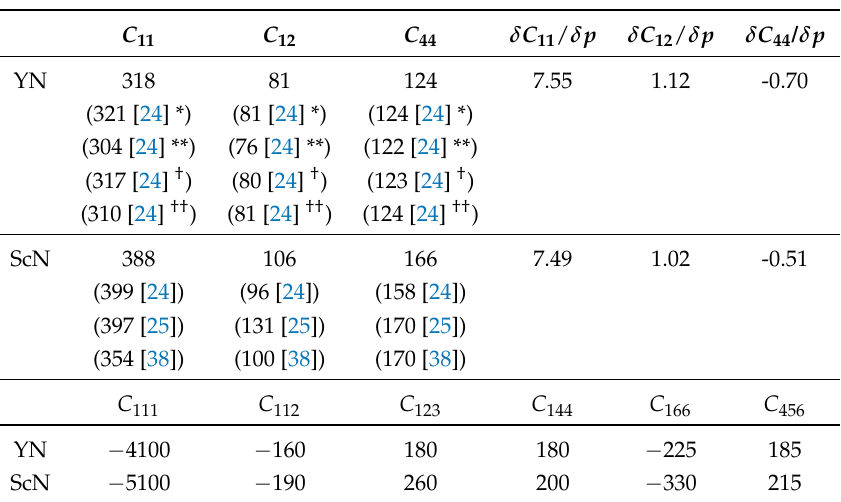
Table 1. Calculated second-order elastic constants C ij ( p = 0 GPa) (in comparison with selected literature values—when a GGA was used as in our case) and their pressure changes ( δ C 11 / δ p , δ C 12 / δ p , and δ C 44 / δ p ) as approximatively evaluated for δ p = 1 GPa from computed third-order elastic constants C ijk ( p = 0 GPa). Theoretical values taken from Ref. [24] are related to GGA-PW91 approximation [33] similarly as in our case (marked by ∗ ), GGA-PW91 + U (marked by **), GGA-PBE [41] (marked by † ) or GGA-PBE + U (marked by ††